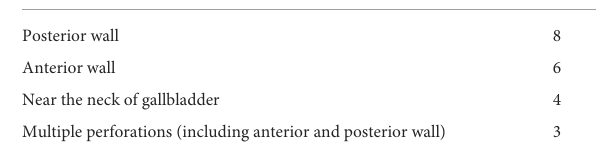
TABLE 1 Perforation location of choledochal